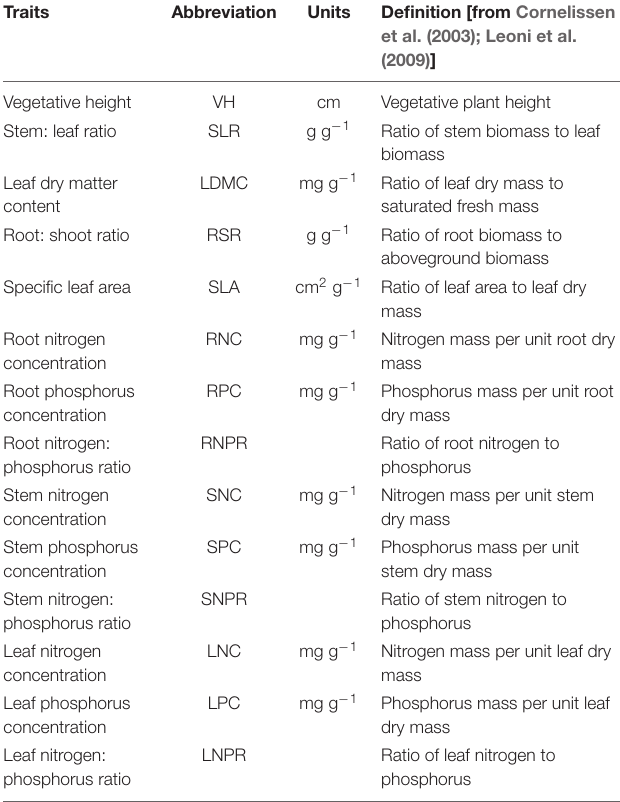
TABLE 2 | Plant functional traits and measurement